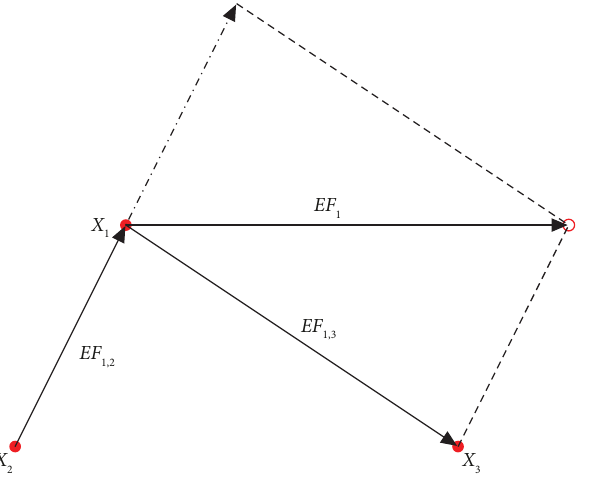
Figure 1: Exertion of forces on X